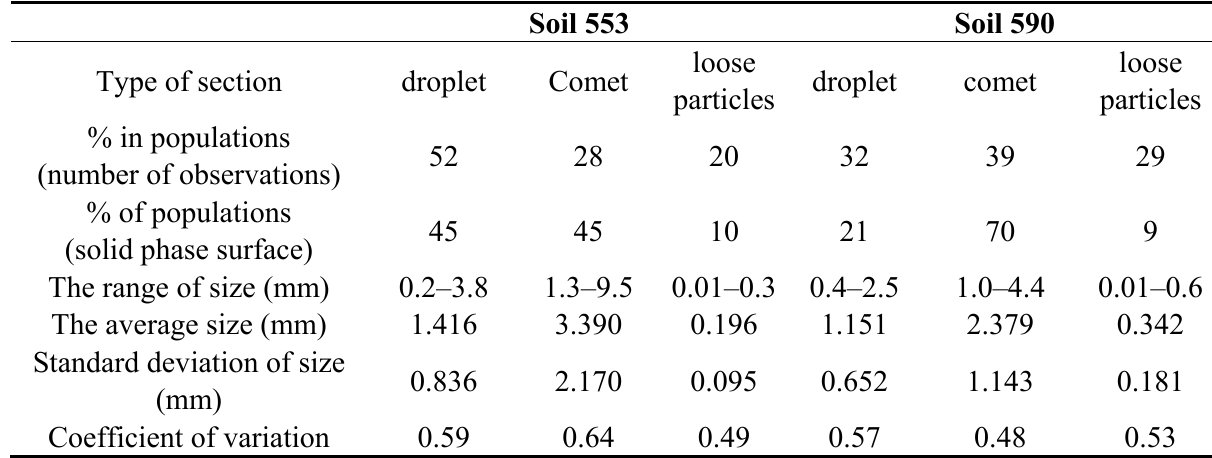
Table 2. Characteristics of particles obtained as a result of splash. Soil 553 Soil